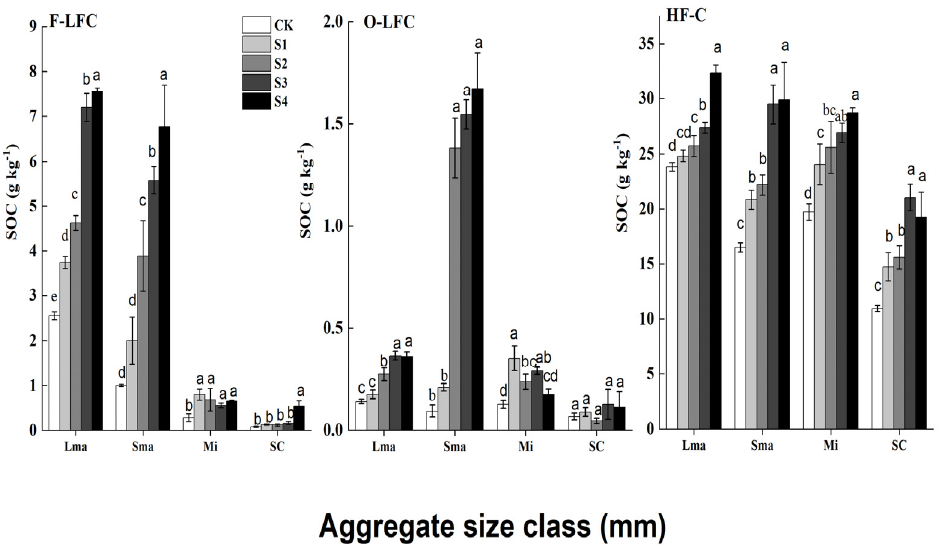
Figure 4. Effects of straw return on the density fractions of soil organic carbon in the aggregate size classes. >2.00 mm, large macroaggregates; 2.00–0.25 mm, small macroaggregates; 0.25–0.053 mm, microaggregates; <0.053 mm, silt plus clay. F-LFC, free light fraction carbon; O-LFC, occluded light fraction carbon; HF-C, heavy fraction carbon. Different letters within a size fraction denote significant differences between treatments ( p < 0.05). CK, S1, S2, S3, and S4 represent rates of return of corn straw of 0, 6000, 9000, 12,000, and 15,000 kg hm − 2 , respectively. 3.5. Relationships among Straw Return, SOC Indicators, and Aggregate Indicators SEM with straw return indicated that RMSEA (0.000), GFI (0.985), and CFI (1.000) pro- returned had the largest effect on SOC content, light fraction C (LFC), and WSA >0.25mm ( p < 0.001). Straw return significantly affected heavy fraction C (HFC) ( p < 0.01). GMD was significantly affected by straw return ( p < 0.05) (Figure